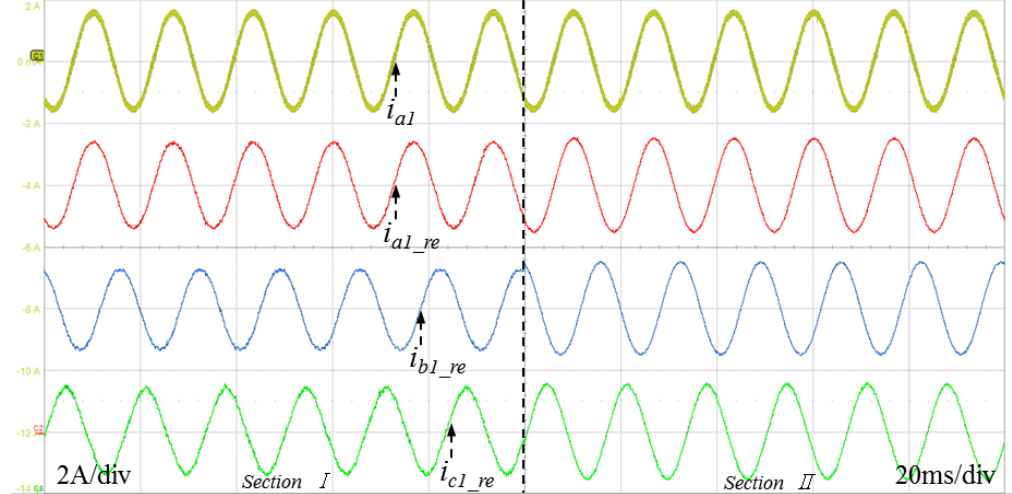
Figure 11. The actual current and reconstructed currents of the three phase current before and after the proposed offset compensation algorithm is applied in the inverter 1.